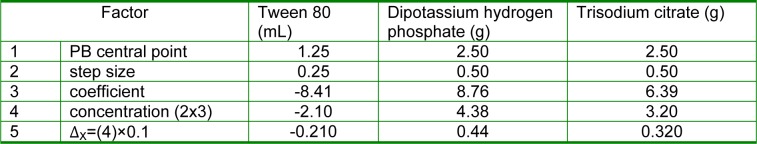
Fermentation process optimization of EPS produced by activated L. acidophilus ATCC. The design of the steepest ascent experiment